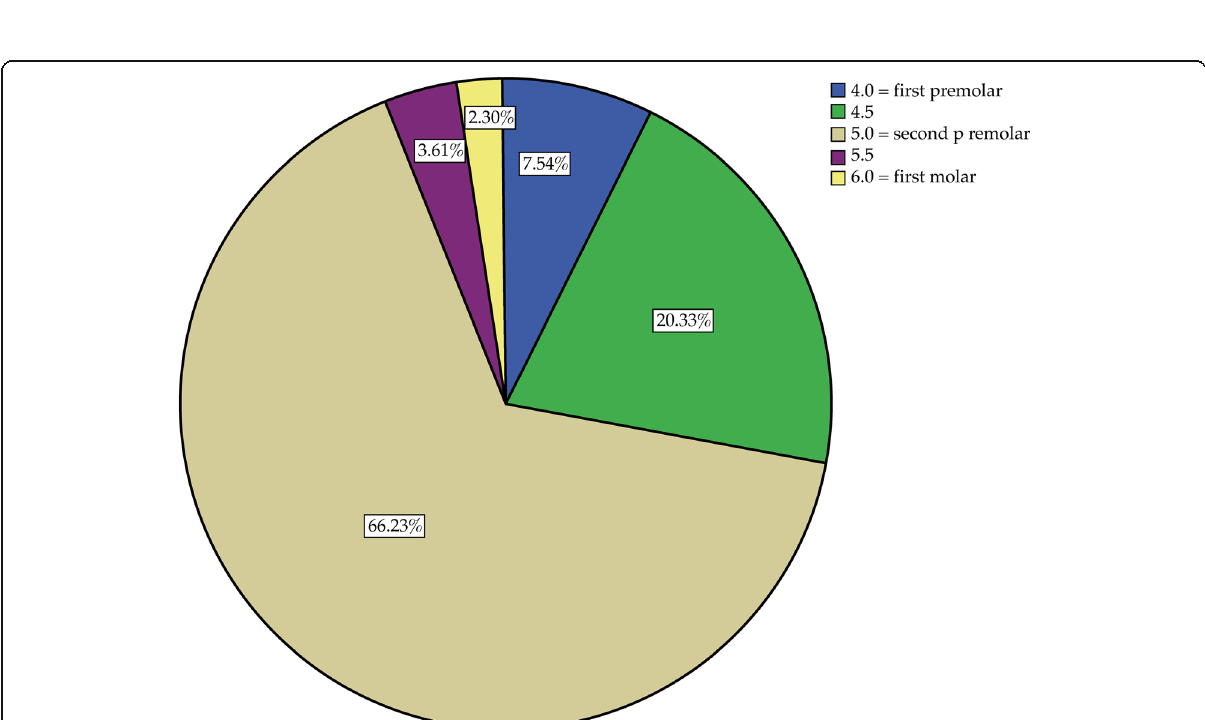
Fig. 6 Position of the right mental